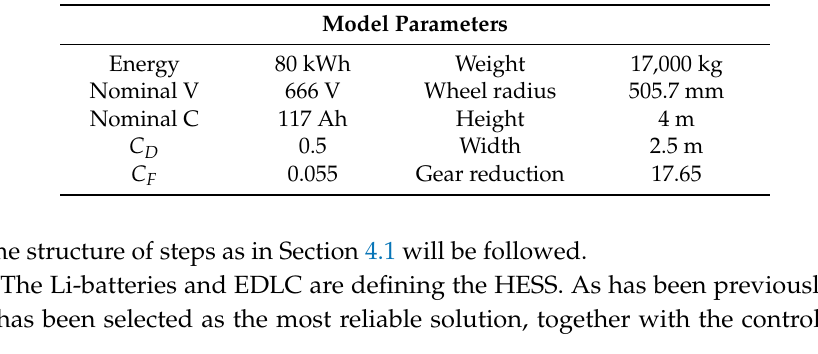
Table 2. Castrosua Tempus Hybrid Parameters.